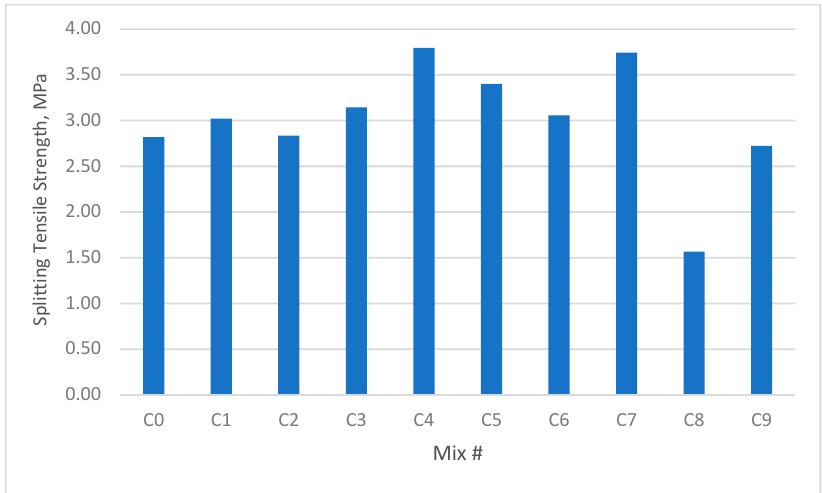
Figure 8. Splitting tensile strength of concrete beams with W/B ratio 0.3.